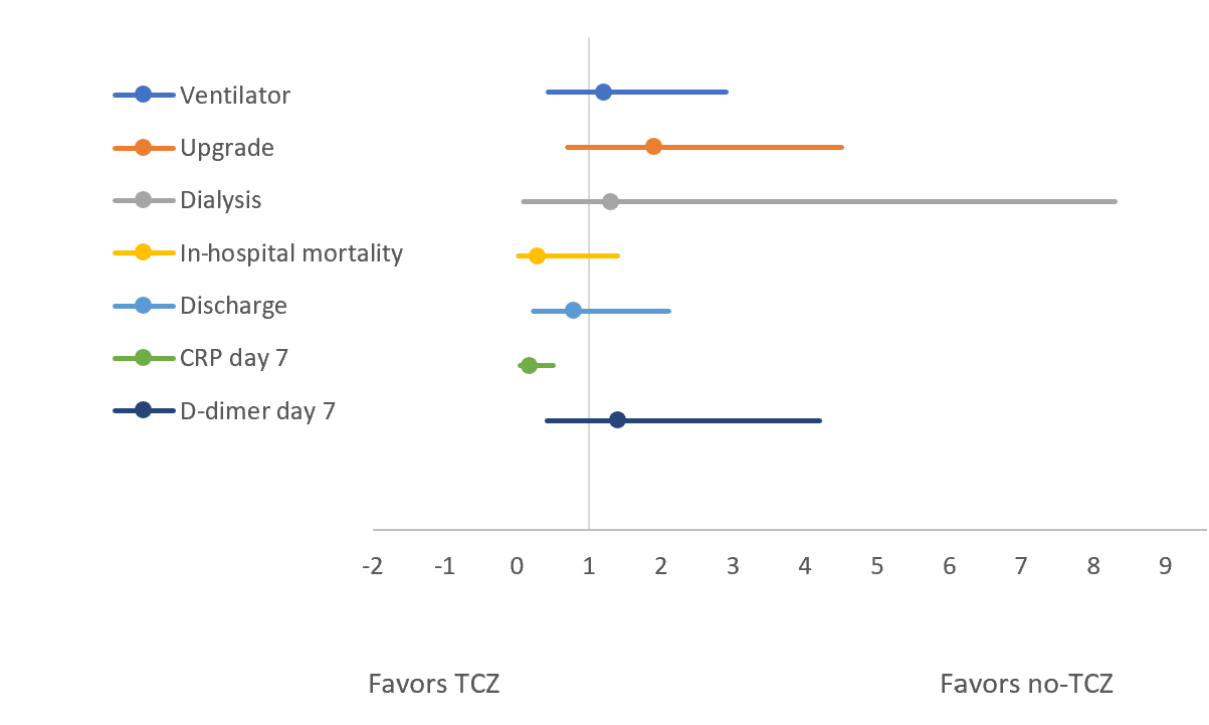
Figure 3. Forest plot comparing adjusted odds of outcomes between the tocilizumab (TCZ) and no-TCZ groups. CRP: C-reactive protein.